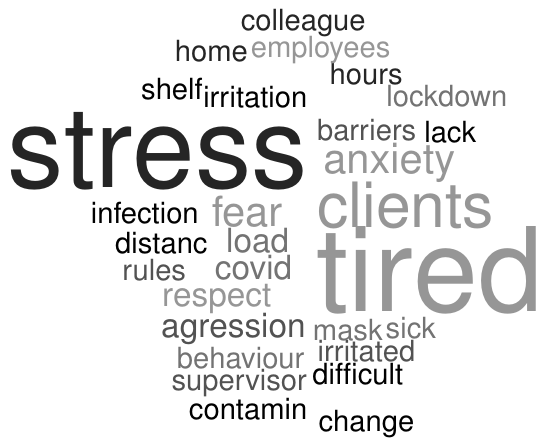
Figure 3. Mood change description of employees (derived from free